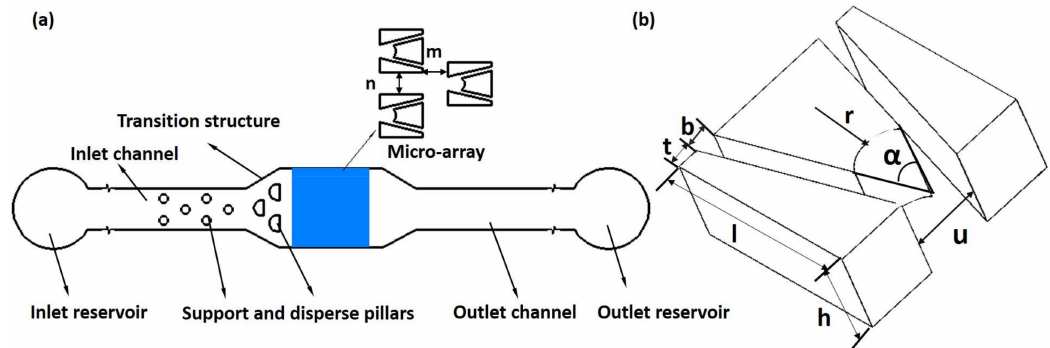
Figure 2. The schematic diagram of the chip: ( a ) the overall structure; ( b ) the double-slit